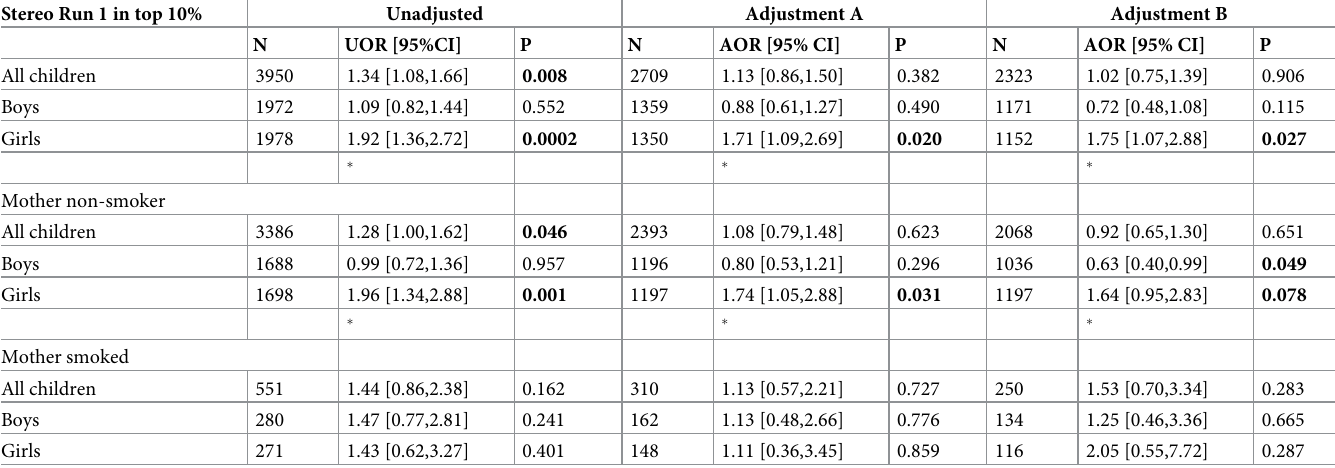
Table 6. Odds ratio showing risk of stereo run 1 volume level being in the top 10% where maternal grandmother smoked. Adjustment A concerns allowing for mater- nal grandmother’s year of birth, her ethnicity, her education level; Adjustment B additionally takes the maternal grandfather’s social class into account. Stereo Run 1 in top 10%